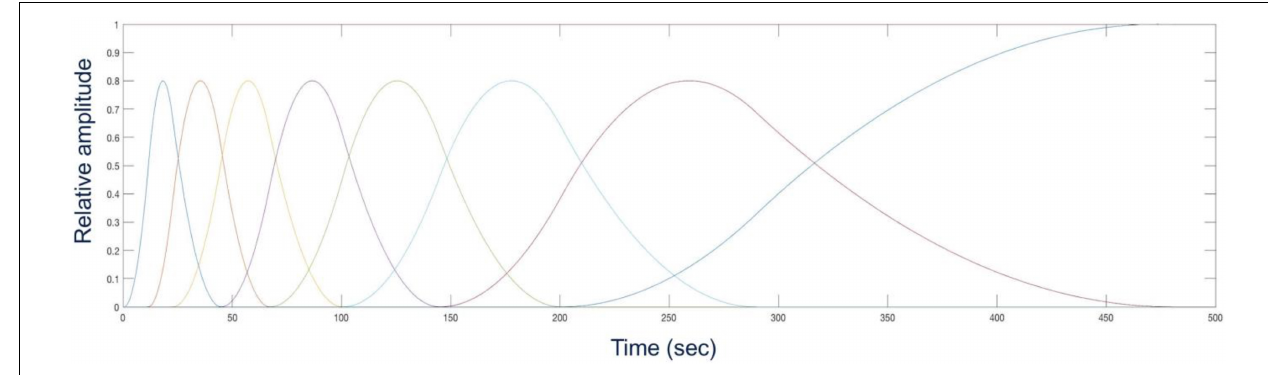
FIGURE 8 | A representative set of temporal cubic B-spline basis functions that were optimized for a specific input time activity curve (TAC) in Figure 3 .